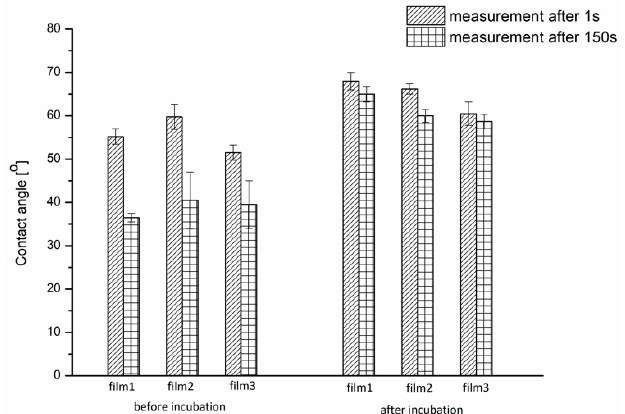
Figure 4. Θ values for P(iPrOx-nPrOx) films in the dry state at room temperature and after incubation in water at 40 °C and measured at 40 °C.